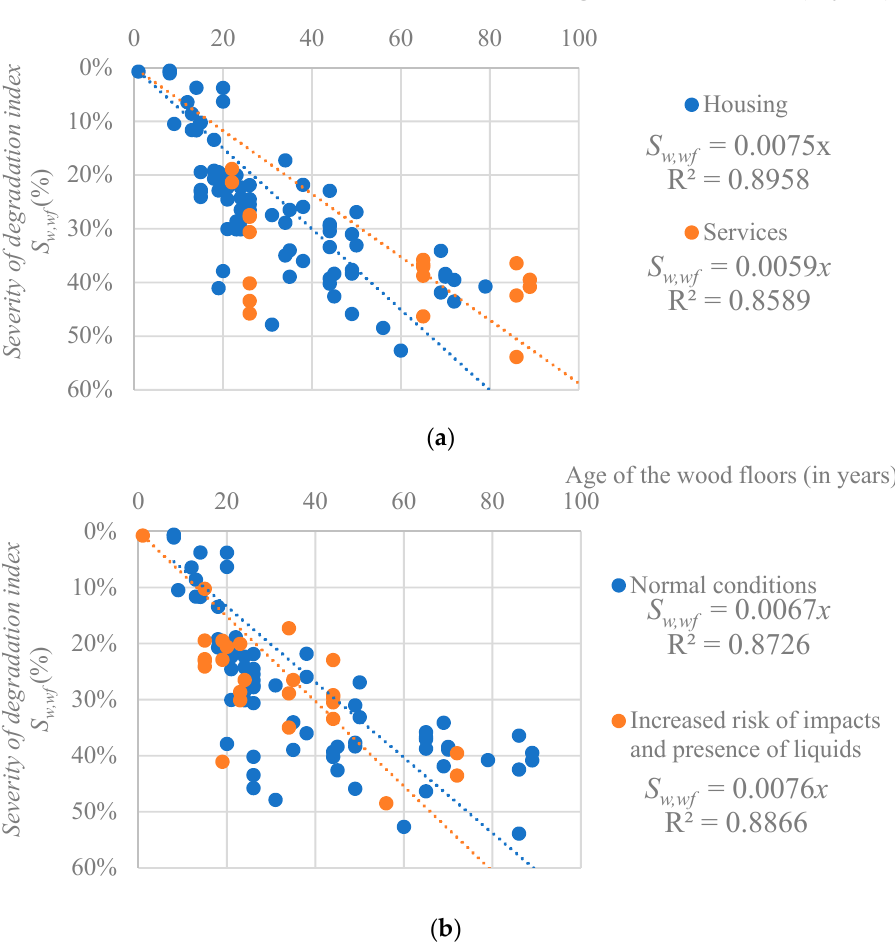
Figure 9. Regression analysis between the numerical index that expresses the degradation of the 96 wood flooring systems ( S w,wf ) and their age, according to the type of use ( a ) and in-use conditions ( b ).